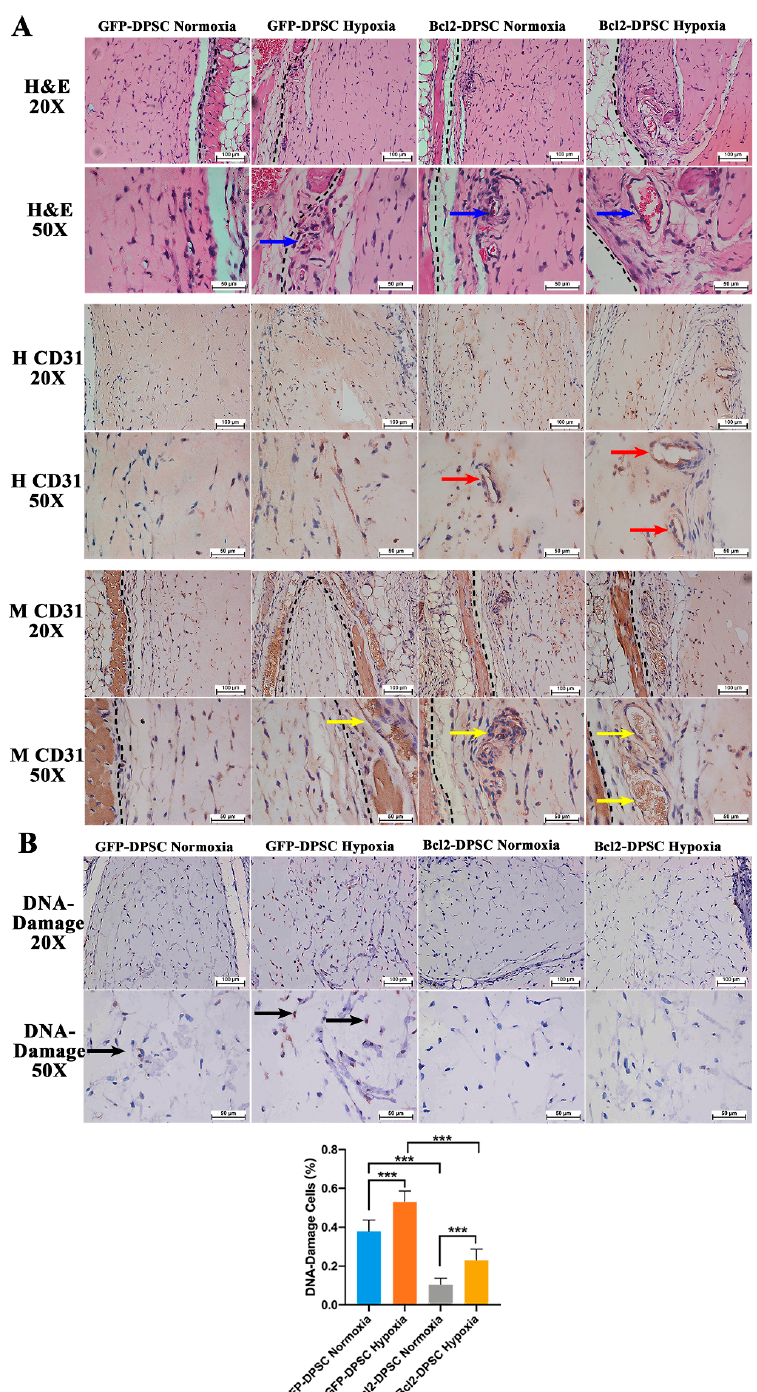
Figure 6. In vivo Matrigel plug assay: ( A ) Representative microscopic images of hematoxylin and eosin (H&E) (20 × and 50 × magnification) and immunohistochemistry for human CD31 (H CD31; 20 × and 50 × magnification) and mouse CD31 (M CD31; 20 × and 50 × magnification) of Matrigel plugs at 7 days of implantation. Broken black lines—interface between the mouse tissue and the Matrigel plug. Blue arrows—perfused blood vessels. Red arrows—human CD31 positive non-perfused lumens. Yellow arrows—mouse CD31 positive perfused blood vessels. ( B ) Representative microscopic images of immunohistochemistry for DNA damage (20 × and 50 × magnification) and quantified percentage cells with DNA damage. Black arrows—DNA damage positive cells. *** p < 0.001 versus the corresponding